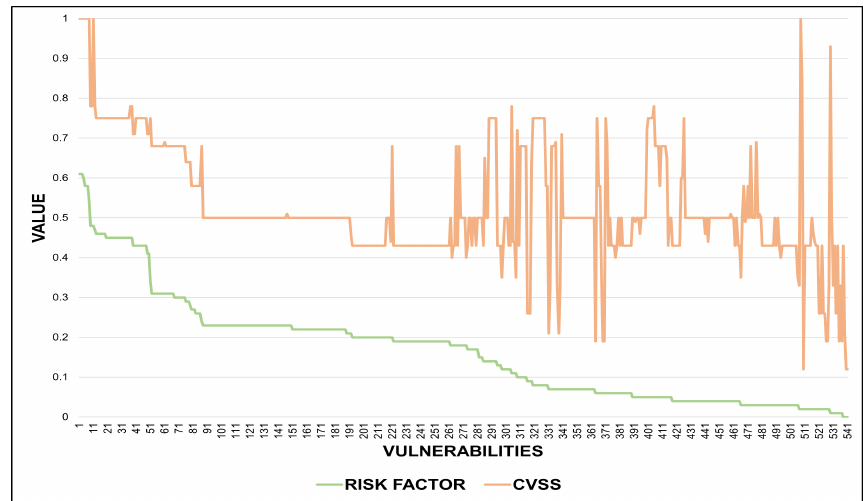
Figure 11. CVSS trend and risk factor by vulnerability. If an organization relies only on CVSS, it runs the risk of wasting much time, evaluating vulnerabilities that do not represent a priority risk because environmental variables mitigate the impact and probability of occurrence. This waste of time generates economic losses and increases the organization’s